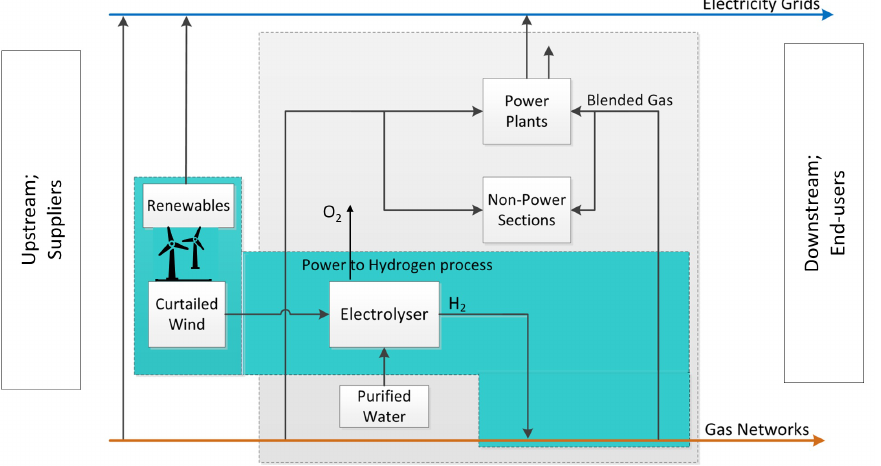
Figure 1. Power to gas process diagram and proposed case study process highlighted in green